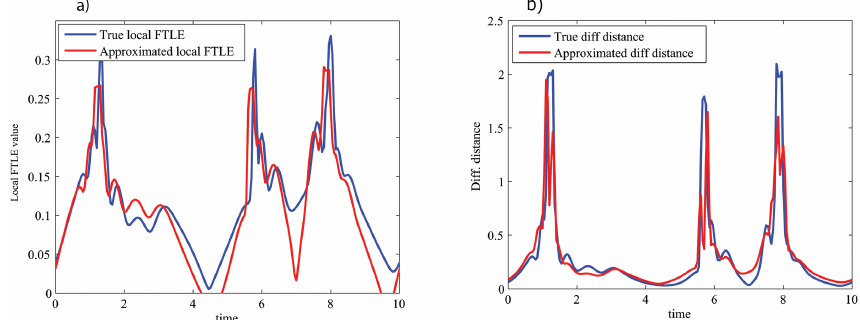
Figure 5. Observations I and II at ( x , y ) = (0.3, 0.4) for a periodic double-gyre velocity field. (a) Local benchmark and recovered forward FTLE. (b) Benchmark and approximated final distance between successively released particles corresponding to T =